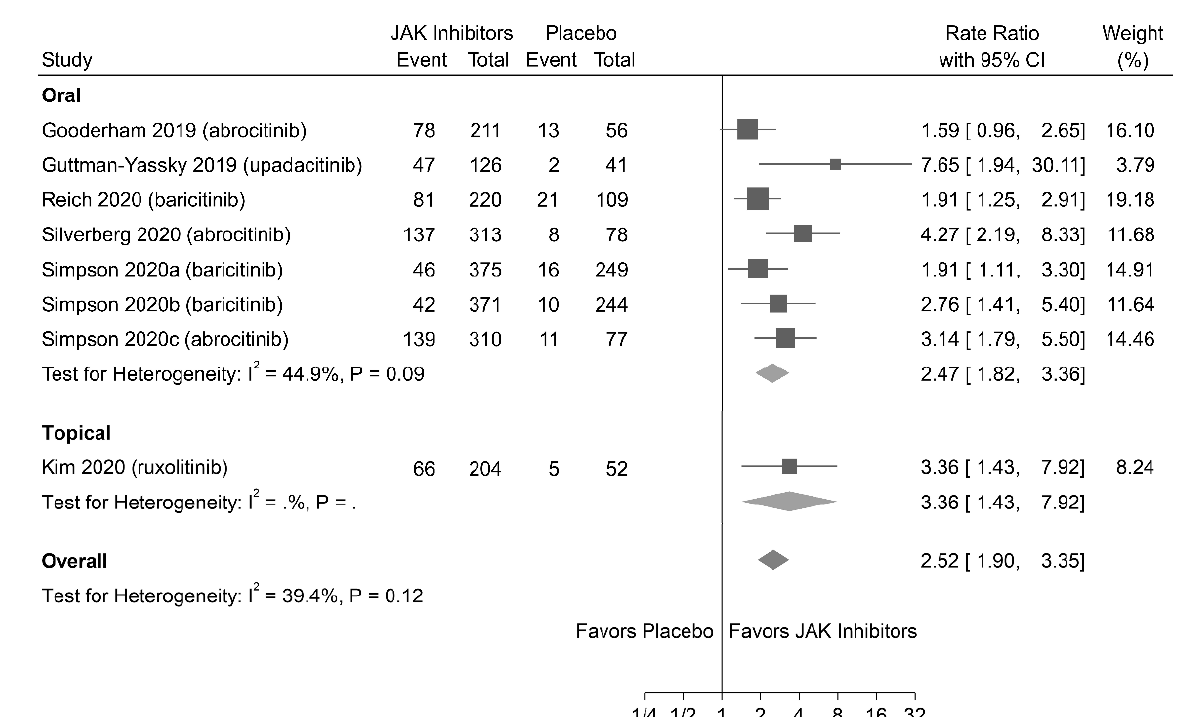
Figure 2. Association of Janus kinase (JAK) inhibitors versus placebo achieving of an Investigator Global Assessment (IGA) of 0 (clear) or 1 (almost clear) with at least a two-point reduction from the baseline (IGA response). CI, confidence interval.